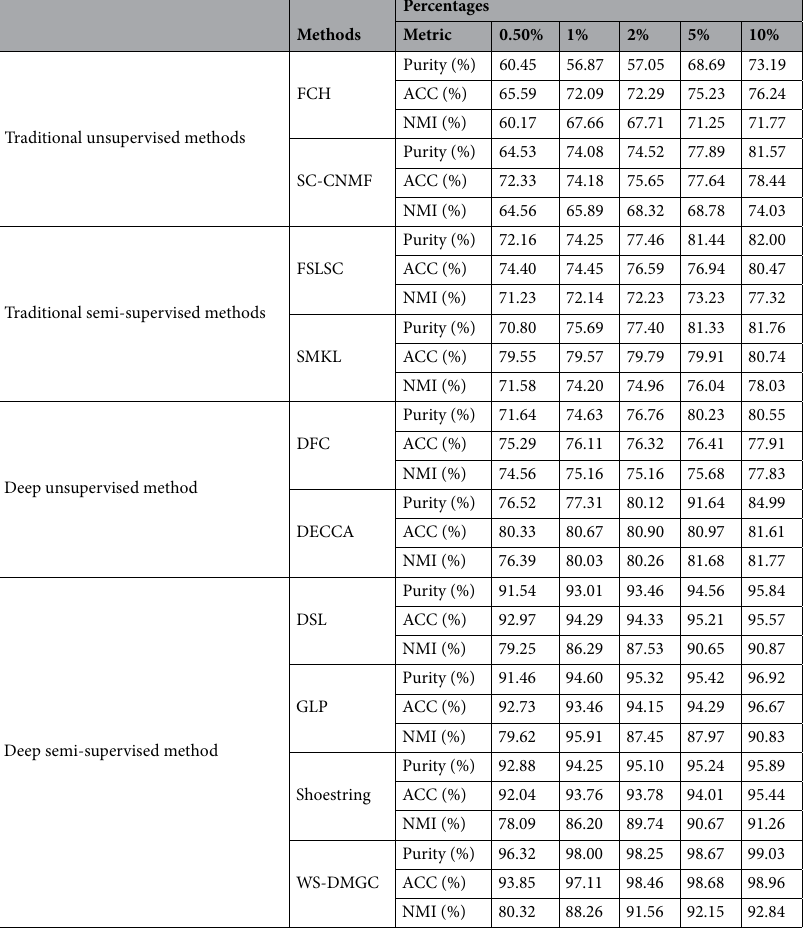
Table 5. Comparison results in terms of three metrics (purity, ACC and NMI) on cooperative hospitals dataset.